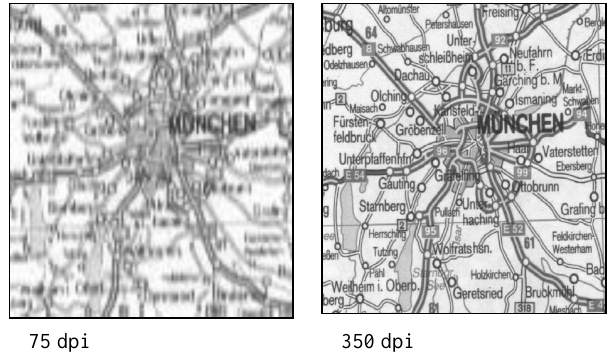
Fig 1. Map scanned with a different resolution